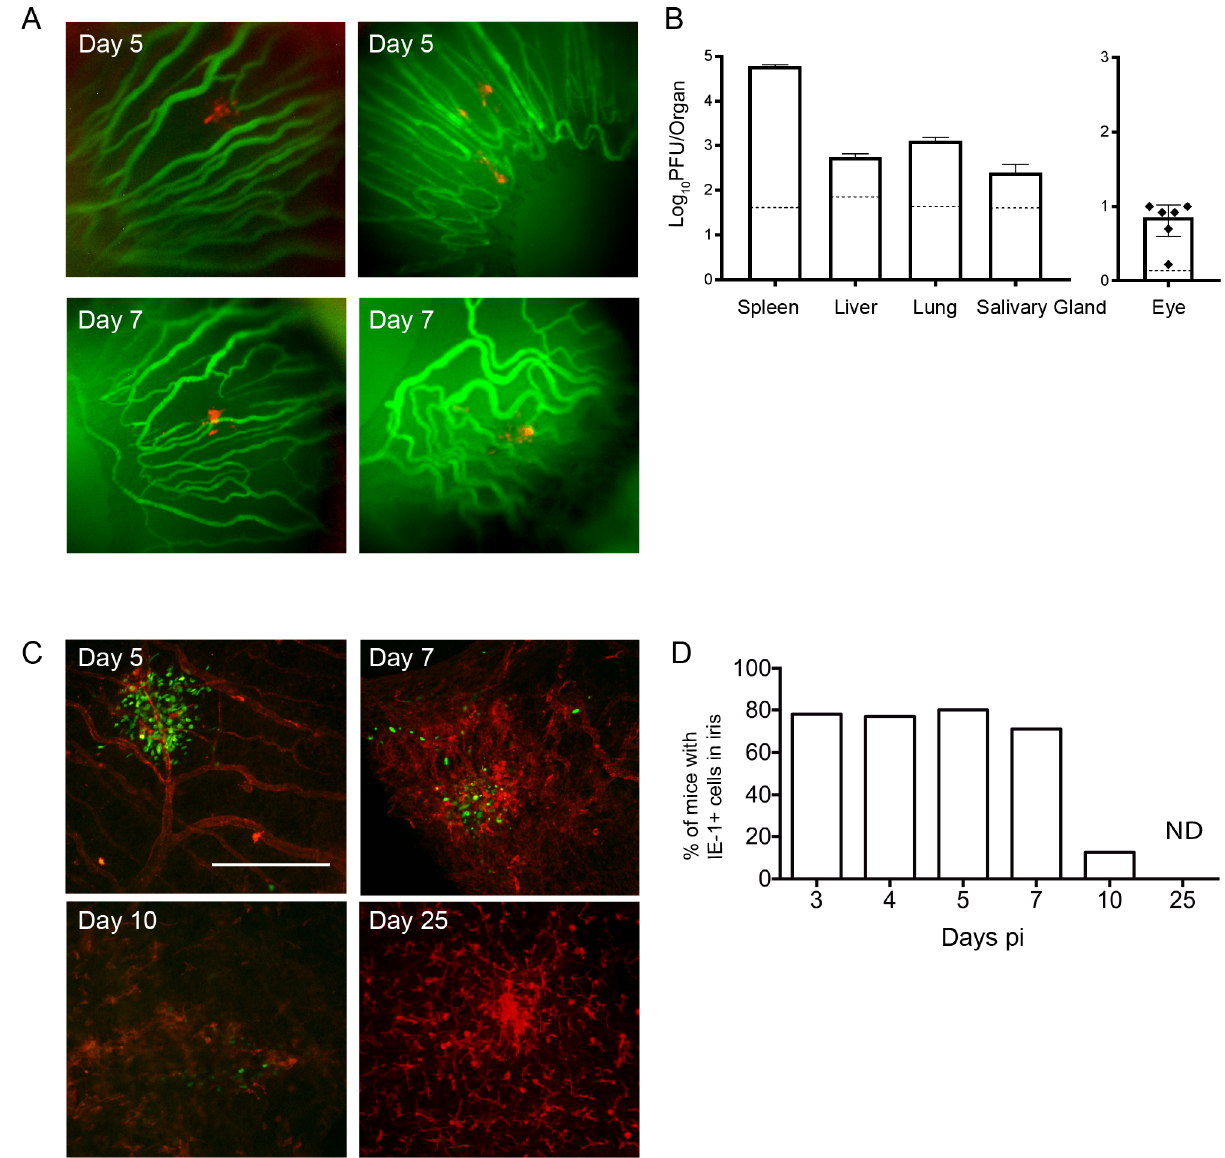
Fig 3. MCMV infects and replicates within the eye after systemic infection. (A) Mice were infected with MCMV-mCherry, and injected with fluorescein prior to in vivo imaging. The iris was assessed using a Micron IV imaging microscope with the vessels staining green and red fluorescence indicating MCMV-infected cells. (B) The indicated organs were removed from MCMV infected mice at day 5 pi, homogenized, and MCMV titres determined by plaque assay. The dashed line represents the limit of detection for individual organs. Mean ± SEM are plotted, where n (cid:21) 5. (C) Whole- mounts of the iris were prepared at various times pi and stained with antibodies directed against MHC-II (red) and the viral antigen IE1 (green). Scale bar: 200 μm (D) The percentage of mice with detectable MCMV in the iris at various times pi is shown where n (cid:21) 9 for each time point. ND = not